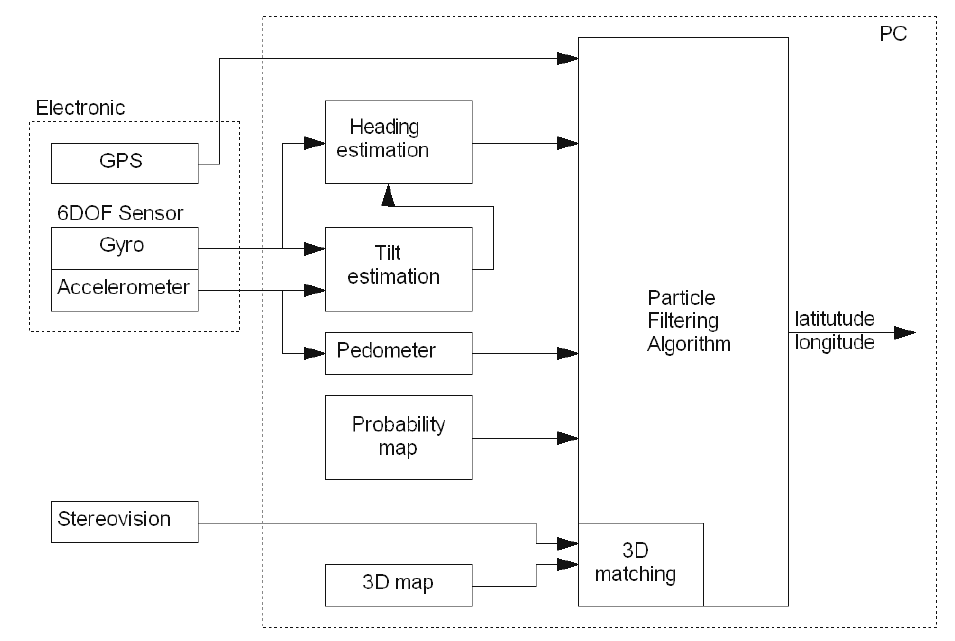
Figure 1. The block diagram of the system. The electronic module is a dedicated electronic circuit comprised of a 6DOF sensor, GPS receiver and microcontroller. The module is connected with the PC via USB interface. The stereovision block represents a stereo